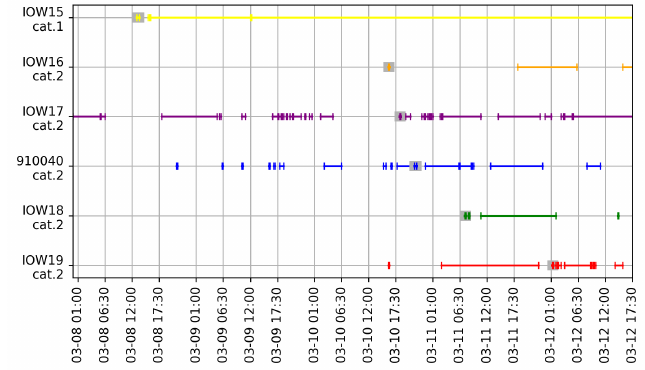
Figure 25. Backwards Flow Path result for Query